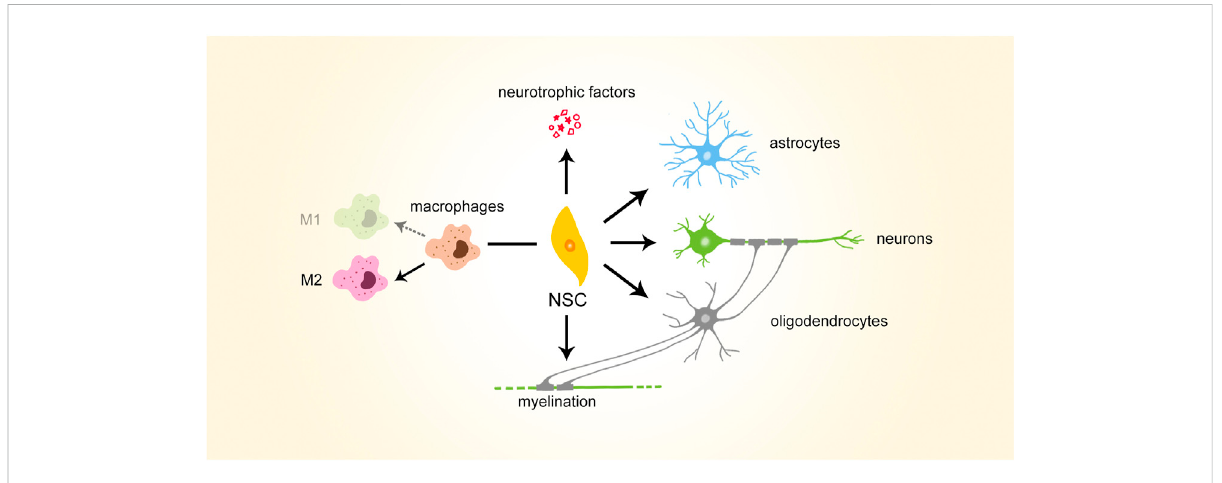
FIGURE 2 Brief illustration of therapeutic potential of NSCs. NSCs, neural stem